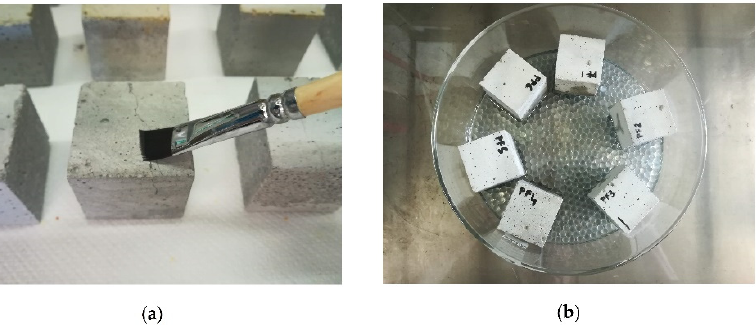
Figure 2. Example of application procedures of CFW: ( a ) brush till refuse, AP1; ( b ) absorption through capillarity, AP2.